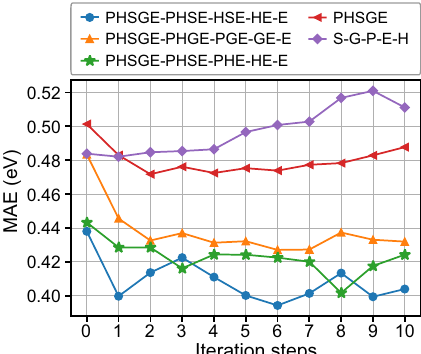
Fig. 10 Application of an iterative procedure for some represen- tative training sequences. The fi rst point of each line is the result obtained with the raw data (i.e., without data cleaning). Every subsequent point is obtained using the model corresponding to the previous point as the denoiser for cleaning the data.